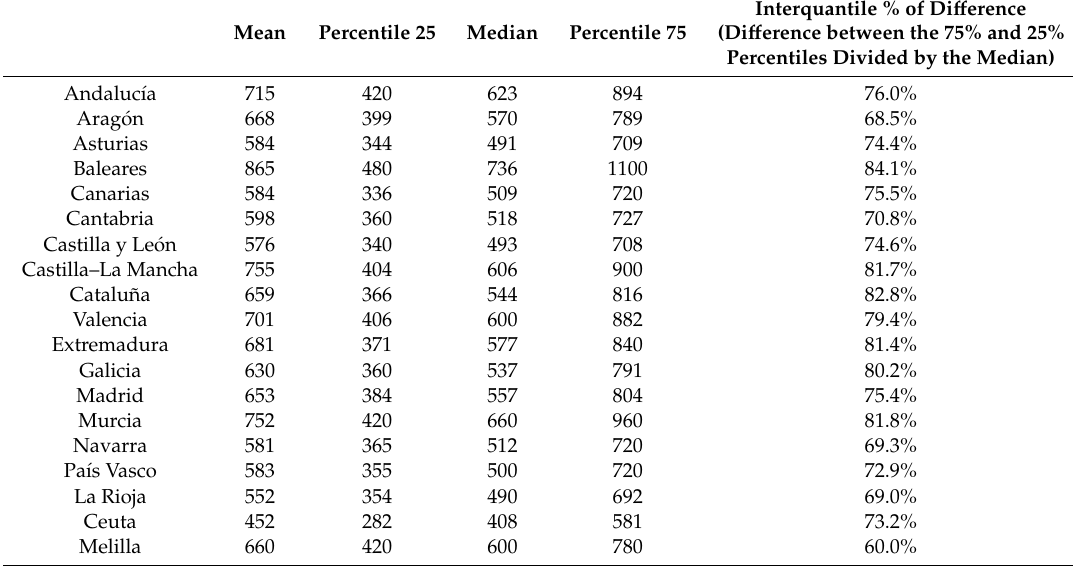
Table 3. Regional electricity consumption per dwelling